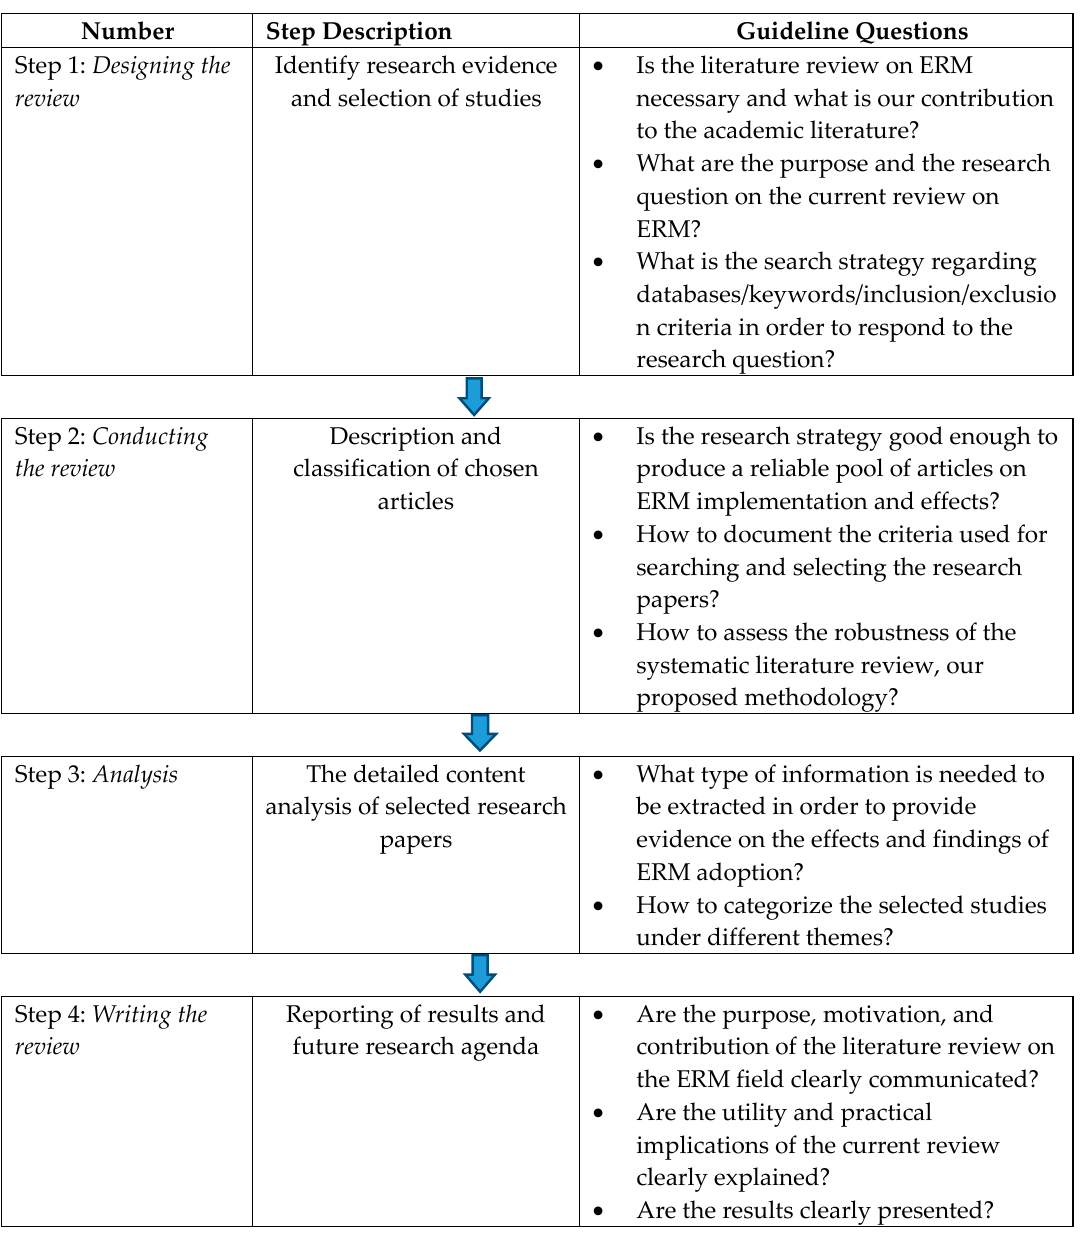
Figure 2. Systematic Literature Review—steps and guideline questions. Source: Adapted from Snyder (2019) and Prasad et al. (2018). Table 1. The breakdown by the document type of the initial pool of contributions on ERM for the period 2008–2019.